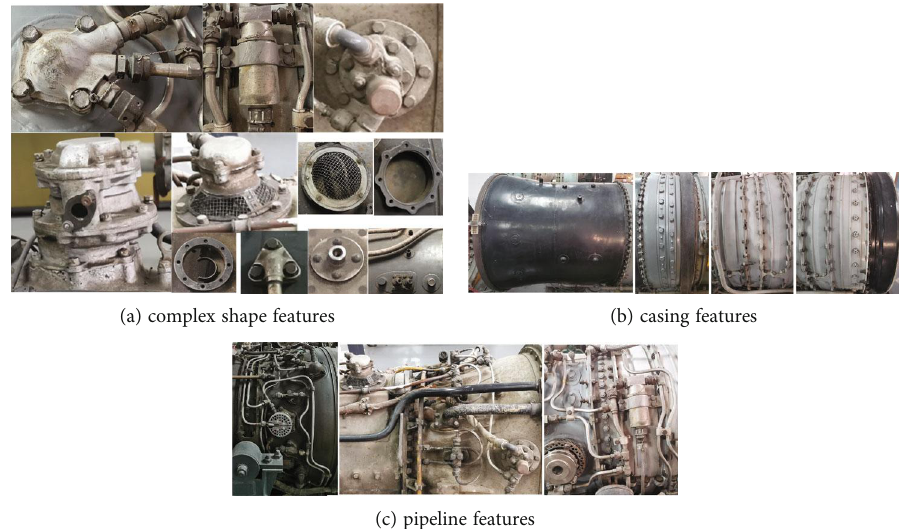
Figure 2: Examples of three types of structural